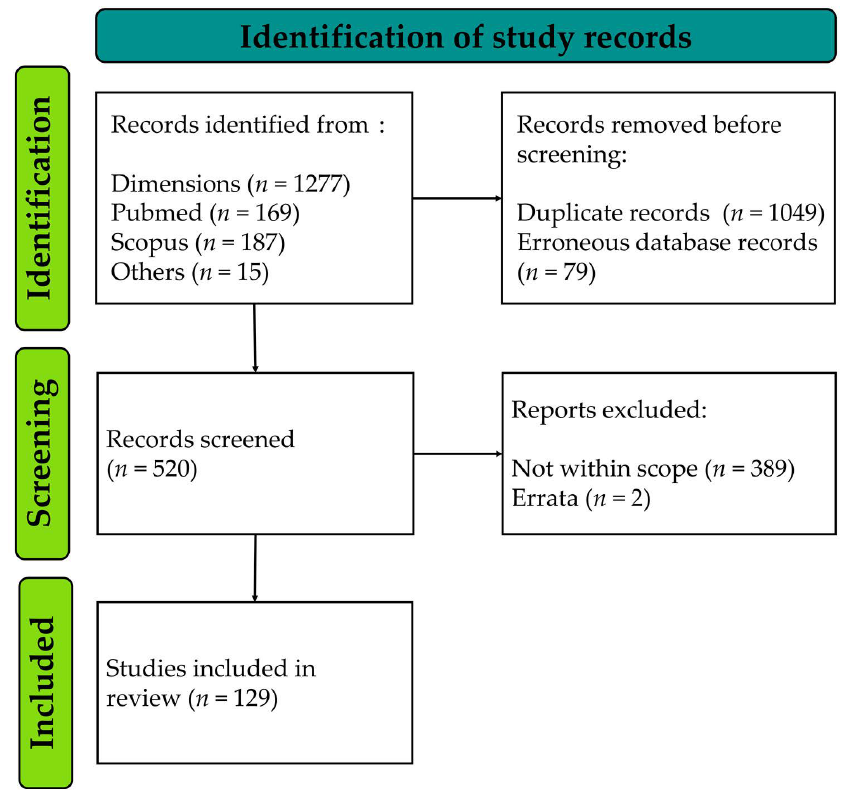
Figure 1. PiCV-related records retrieved from different